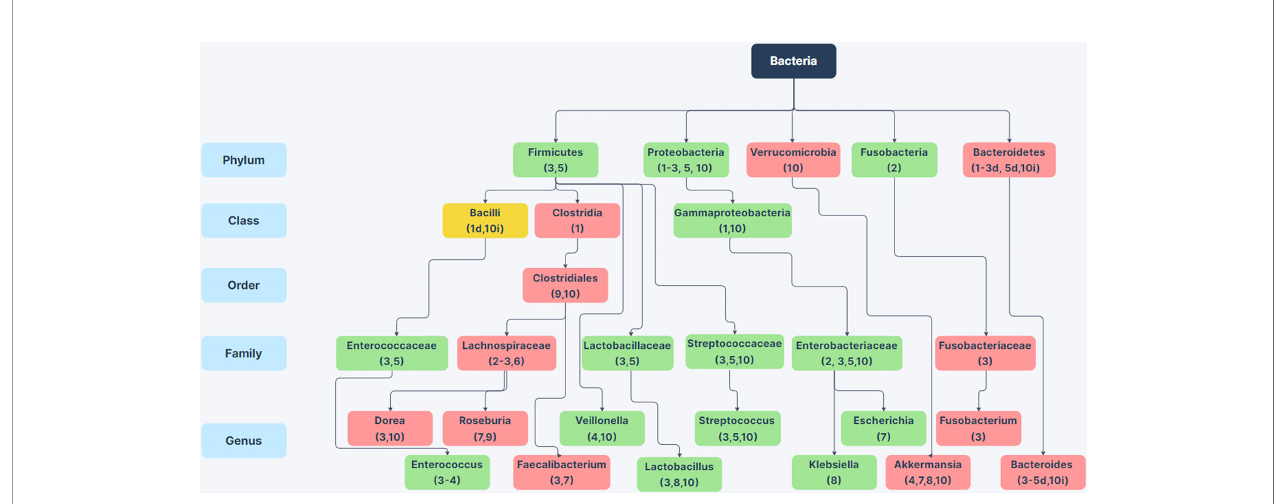
FIGURE 1 | Changes in Bacterial Abundance in the Alcoholic GI Tract. Selected phylum, class, order, family, and genus-level differences in bacterial abundance between the gut microbiome in patients with alcohol-use disorder or varying stages of alcoholic liver disease compared to non-alcoholic humans from 10 human studies. Green boxes indicate taxa with increased abundance in alcoholics (in at least 75% of studies) and red boxes indicate taxa with decreased abundance in alcoholics (in at least 75% of studies). Yellow boxes indicate con fl icting information between studies. Citations are noted below the bacterial name. For taxa with con fl icting information, d or i next to the citation indicates decreased or increased abundance in the alcoholic GI tract. References: (1) Mutlu et al., 2012; (2) Chen et al., 2011; (3) Smirnova et al., 2020; (4) ; Lang et al., 2020b; (5) Tsuruya et al., 2016; (6) Ames et al., 2020; (7) Gurwara et al., 2020; (8) Dubinkina et al., 2017; (9) Seo et al., 2020; (10) Addolorato et al., 2020. Created using Zen Flowchart (www.zen fl